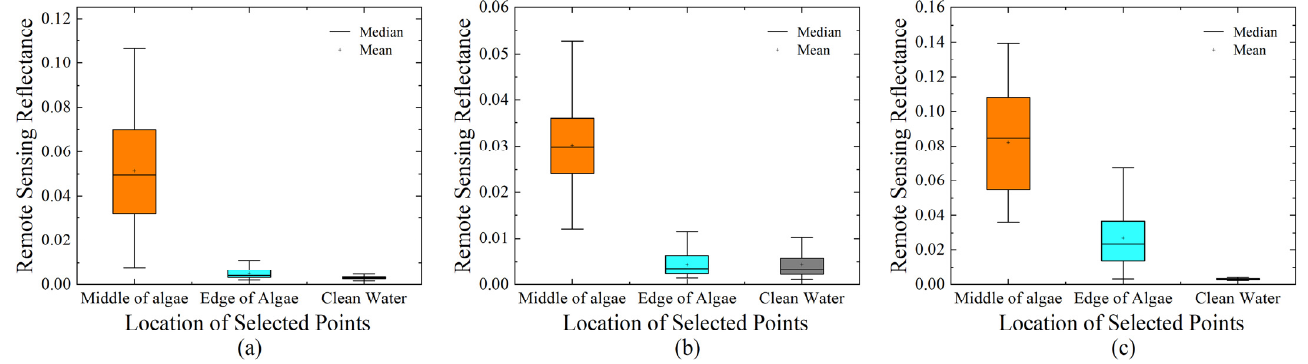
Figure 19. The reflectance of green tide algae, clean water in the data-free area and clean water in the area with retained information: ( a ) GOCI, ( b ) MODIS and ( c ) OLCI.